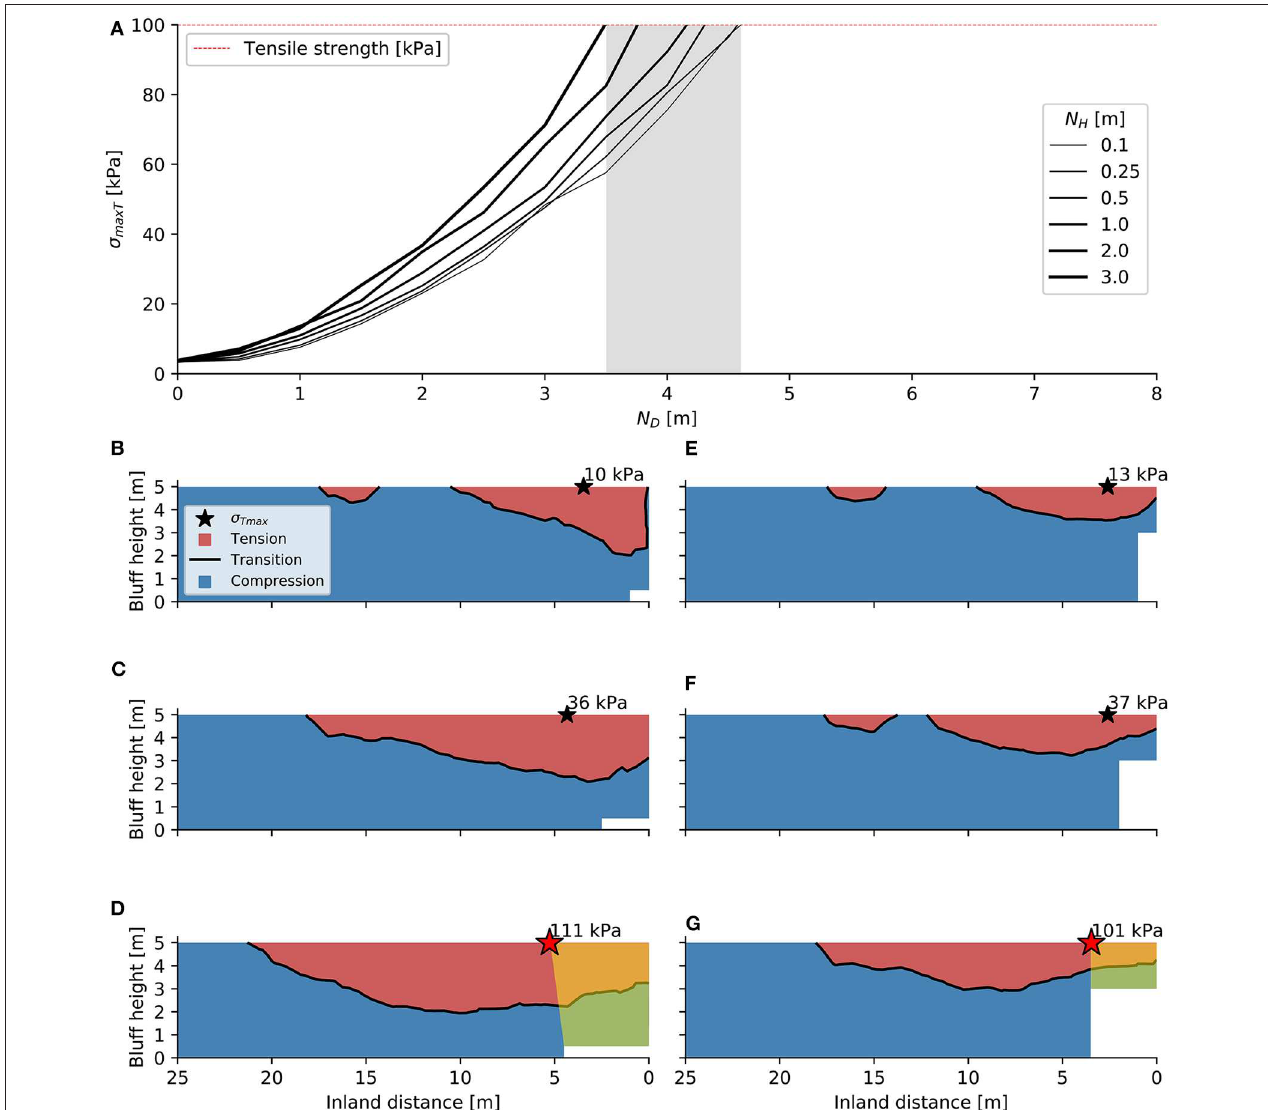
FIGURE 6 | (A) Simulated maximum tensile stress ( σ Tmax ) for six niche height (N H ) scenarios throughout incremental stages of niche depth (N D ) advancement. Snapshots of compressive/tensile stress fields along cross section X-X ′′ ( Figure 3 ) during niche advancement for the (B–D) short and (E–G) tall niche cases. The stars in (B–G) are the σ Tmax location, with a red star indicating a value that the σ Tmax met or exceeded the tensile strength. Yellow shading in (D,G) highlights potential failure areas.